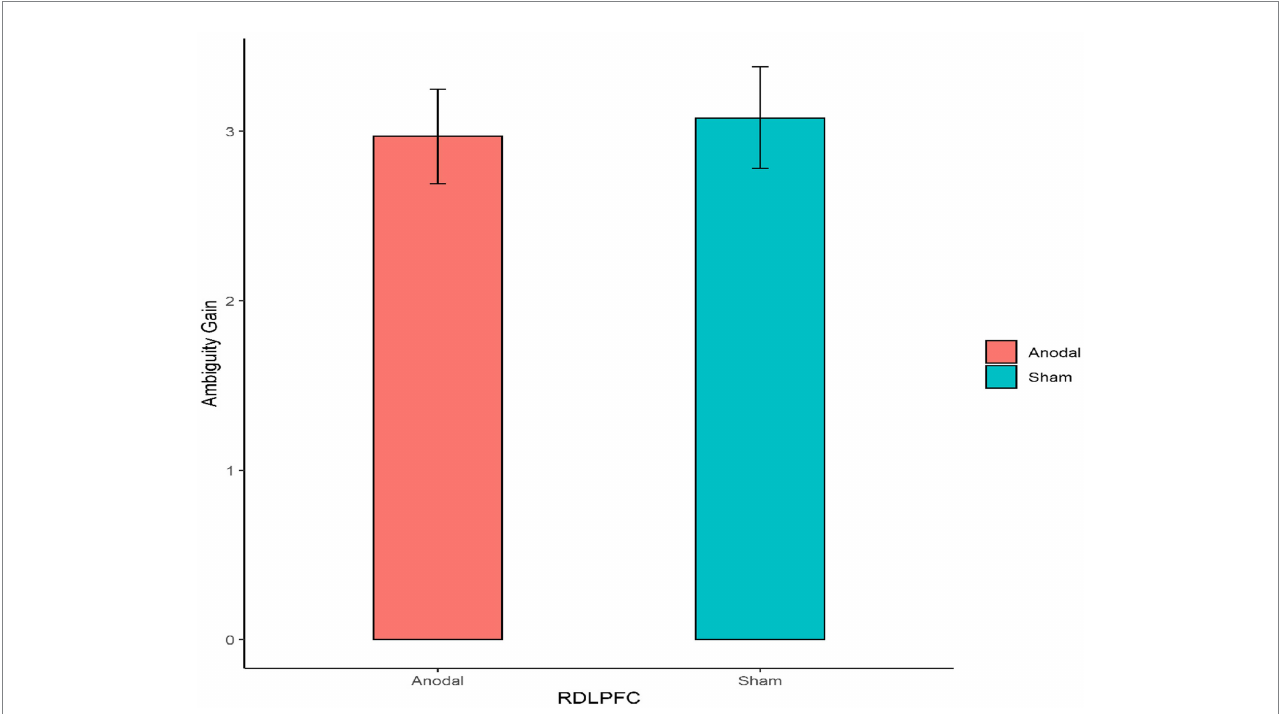
FIGURE 7 The degree of the participants’ attitudes toward ambiguity gain under different right DLPFC stimulation conditions. Error bars represent standard